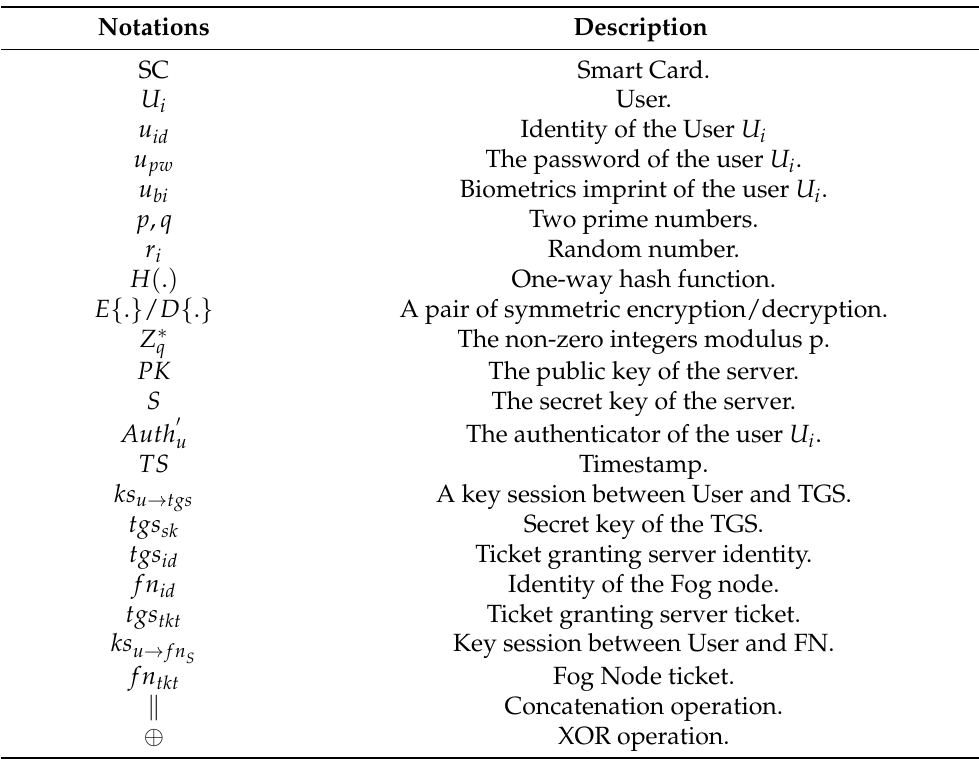
Figure 4. The mutual authentication scheme in fog computing architecture. Table 2. Notation and